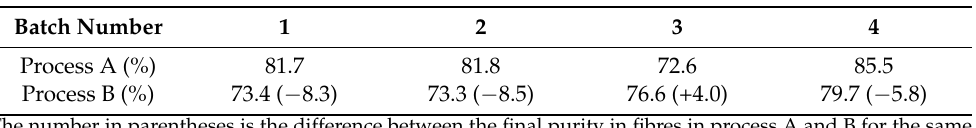
Table 5. Comparison of the final purities in fibres (percentage) for the two processes tested (i.e., A and